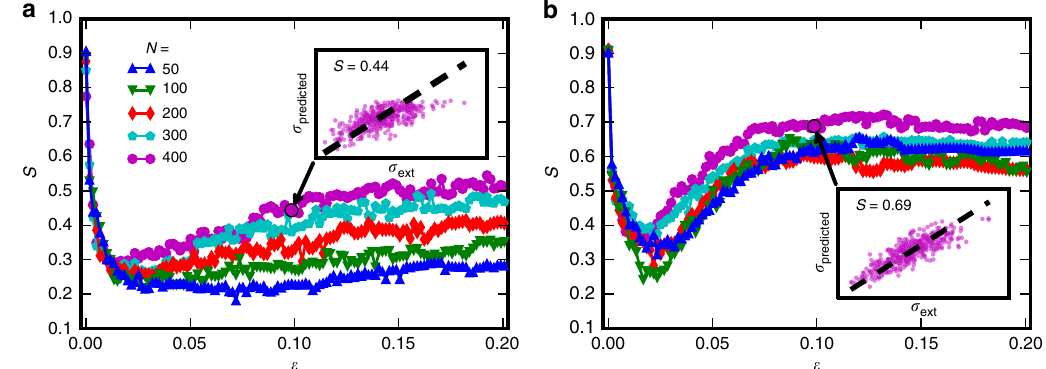
Fig. 2 Predictability of the stress-strain curves: large systems are more predictable for larger strains. Score S of the ANN prediction as a function of strain ε for basic (no pre-strain, ( a )) and ID (with a pre-strain of 0.2, ( b )) systems of different sizes. The insets show example scatter plots of the predicted vs simulated stress values for N = 400 systems at ε = 0.1